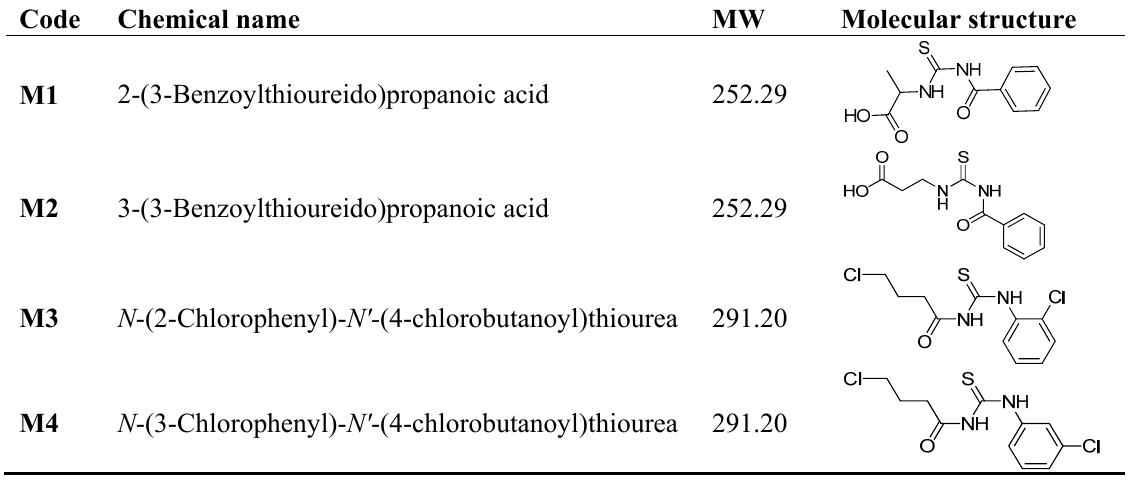
Table 1. The molecular structures of the newly-synthesized carbonyl thiourea